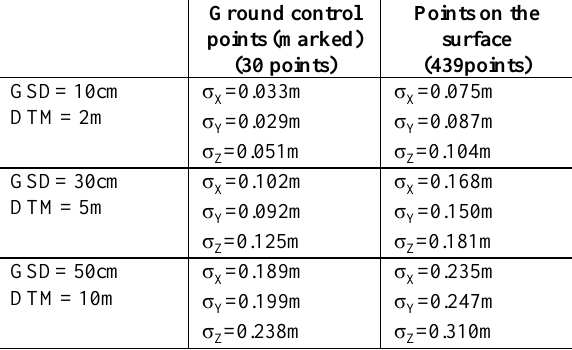
Table 4. Accuracy of the